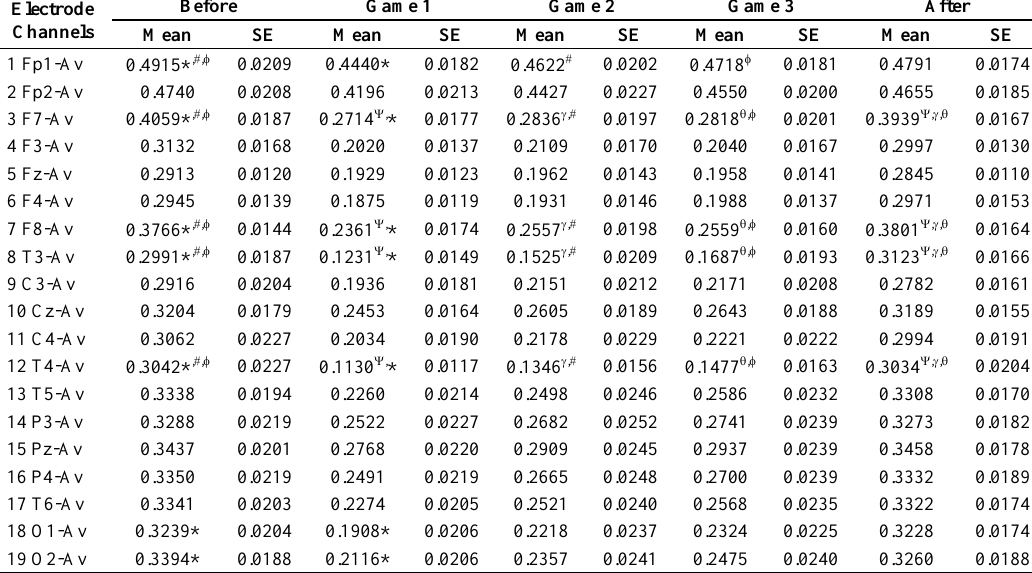
Table 3 Delta relative band powers between non-gameplays and during gameplays (*: before-game1,  : before-game2,  : before-game3,  : after-game1,  : after-game2,  : after-game3, p-value < 0.001) Before Game 1 Game 2 Electrode Channels